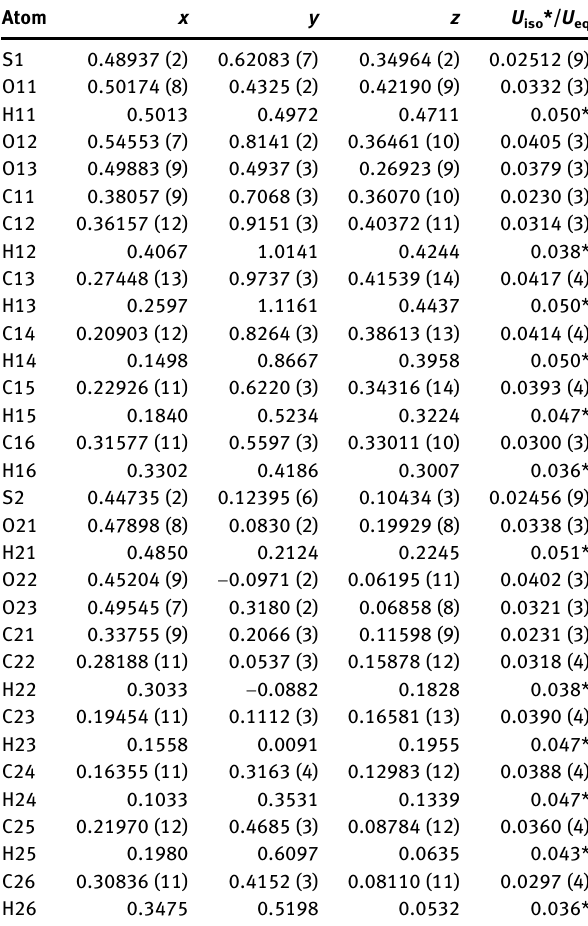
Table  : Fractional atomic coordinates and isotropic or equivalent isotropic displacement parameters (Å 